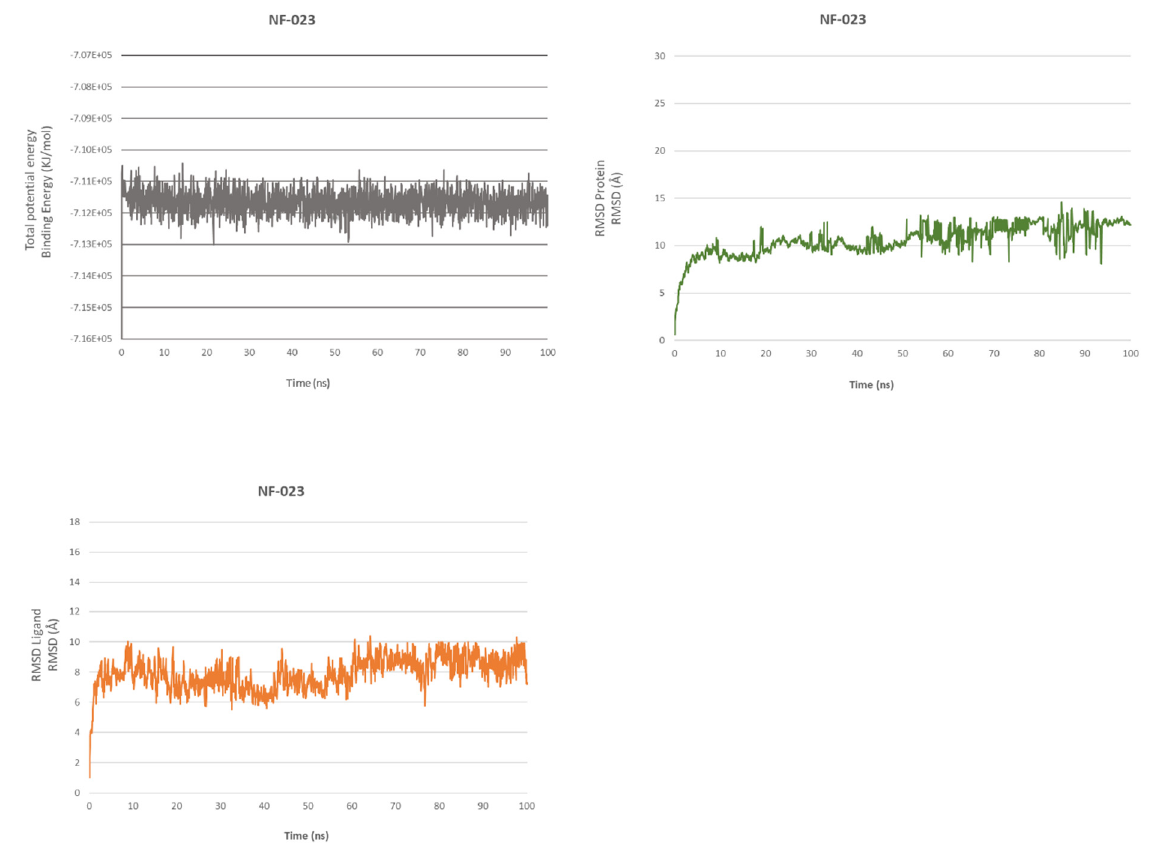
Figure 3. NF 023@HR1 domain. Total energy ( upper left ), RMSDs of protein ( upper right ) and RMSDs of ligand ( lower left ).